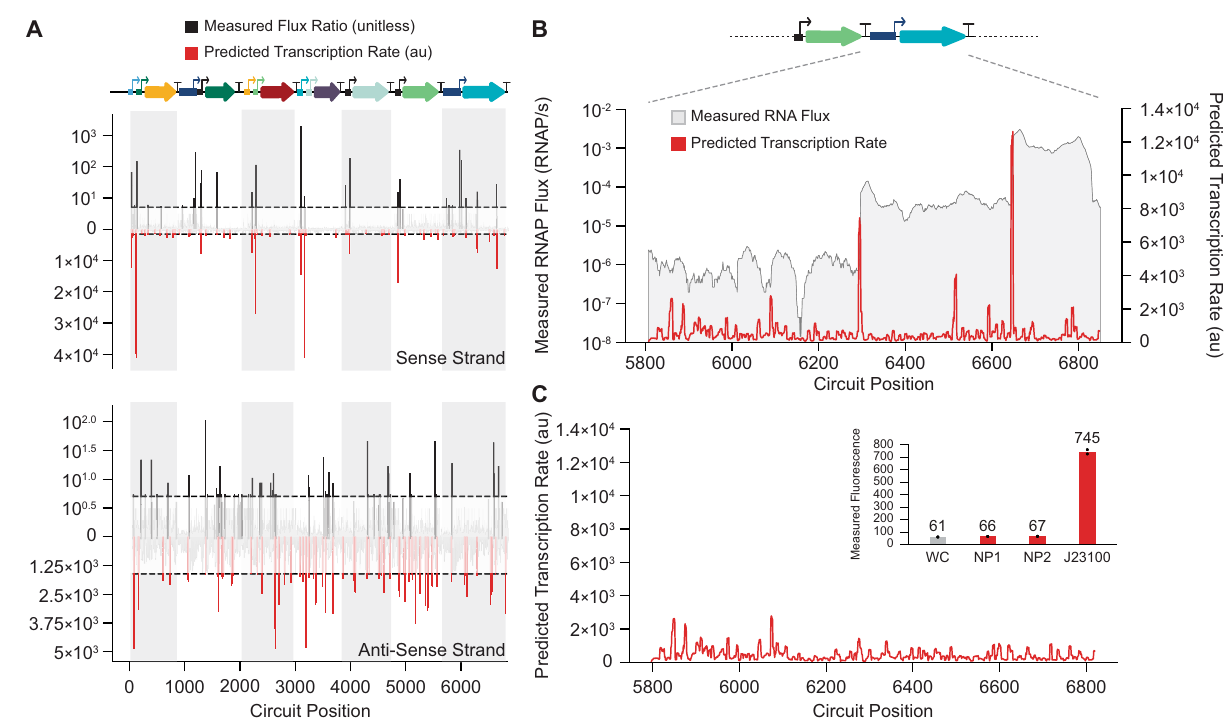
Fig. 6 | Genetic Circuit Debugging Through Cryptic Promoter Identi fi cation. A The predicted σ 70 transcriptional pro fi le of an 11-promoter genetic circuit 8 is compared to in vivo transcription rate and start site measurements on the (top) sense and (bottom) anti-sense strand. Transcription fl ux ratios are the measured differences in adjacent mRNA levels from RNA-Seq. White and gray shadows cor- respond to each transcribed cistron. The horizontal dotted black lines show the minimum transcription rates that de fi ne a start site. Experimental TSS cutoffs are previously described 8 , and prediction cutoffs are de fi ned in the Methods. Anno- tatedstartsitesaredepictedinthecircuitdiagramwitharrows. B Thepredicted σ 70